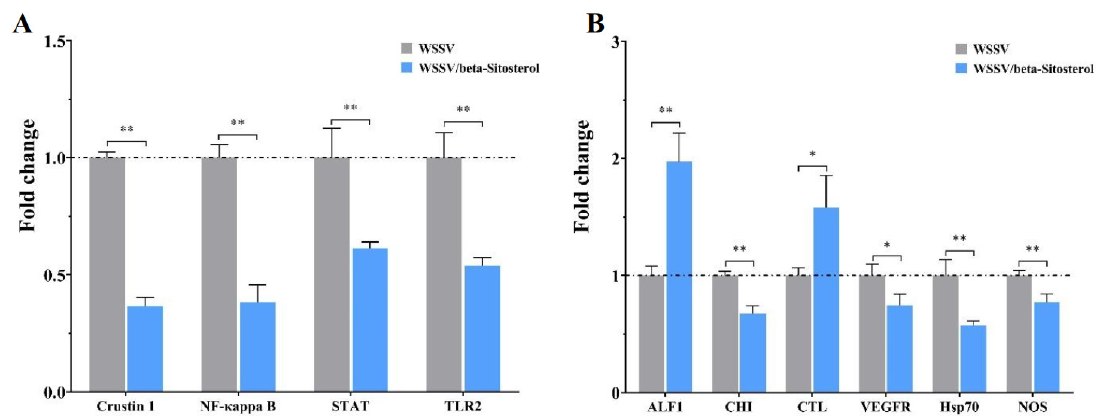
Figure 7. Bbeta-sitosterol regulated the transcription levels of innate immune signaling pathways and immune factor genes in crayfish infected with WSSV (50 mg/kg, 24 hpi). ( A ) Innate immune signaling pathways related genes ( Crustin 1 , NF- κ appa B , STAT , and TLR2 ). ( B ) Other immune factor-related genes (ALF1, CHI, CTL, VEGFR, Hsp70, and NOS). The 18S gene served as an internal reference. The data are shown as mean ± SD (n = 5). Asterisks indicate the significant difference between the experimental and control groups (* p < 0.05, ** p < 0.01).